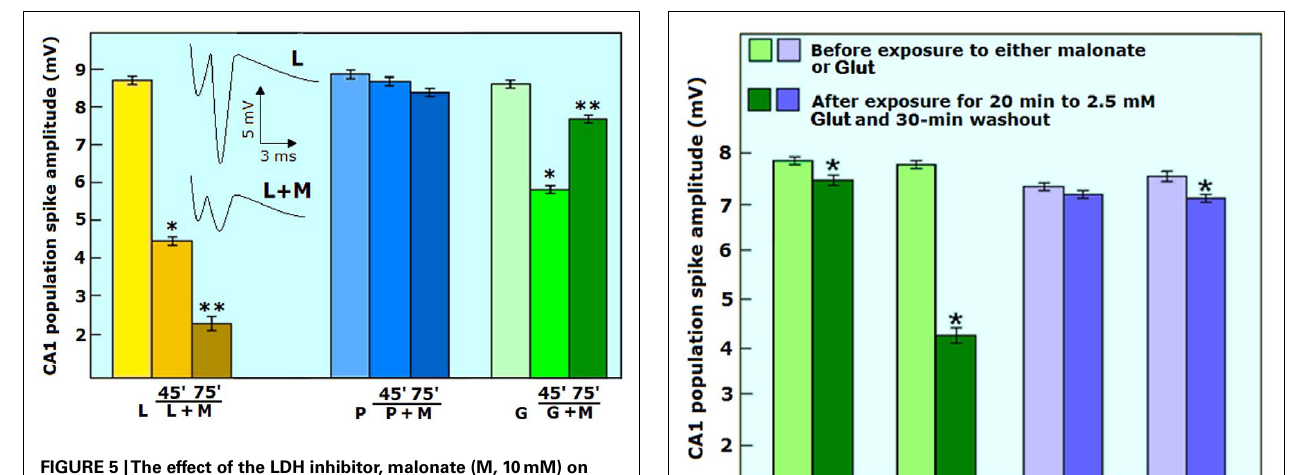
FIGURE 5 |The effect of the LDH inhibitor, malonate (M, 10mM) on evoked CA1 population spike amplitude (neuronal function) of rat hippocampal slices maintained is aCSF containing either lactate (L, 5mM), pyruvate (P, 5mM), or glucose (G, 2.5mM). Malonate progressively inhibited lactate-supported neuronal function over time and was innocuous against pyruvate-supported neuronal function. Malonate initially inhibited glucose-supported neuronal function, inhibition that was later mostly relieved. Each data point was repeated three times (30–36 slices over all). Bars are means ± SEM; *significantly different from energy substrate alone; **significantly different from energy substrate or energy substrate + malonate at 45min ( p < 0.0001). For additional methodological details see Schurr and Payne (2007).